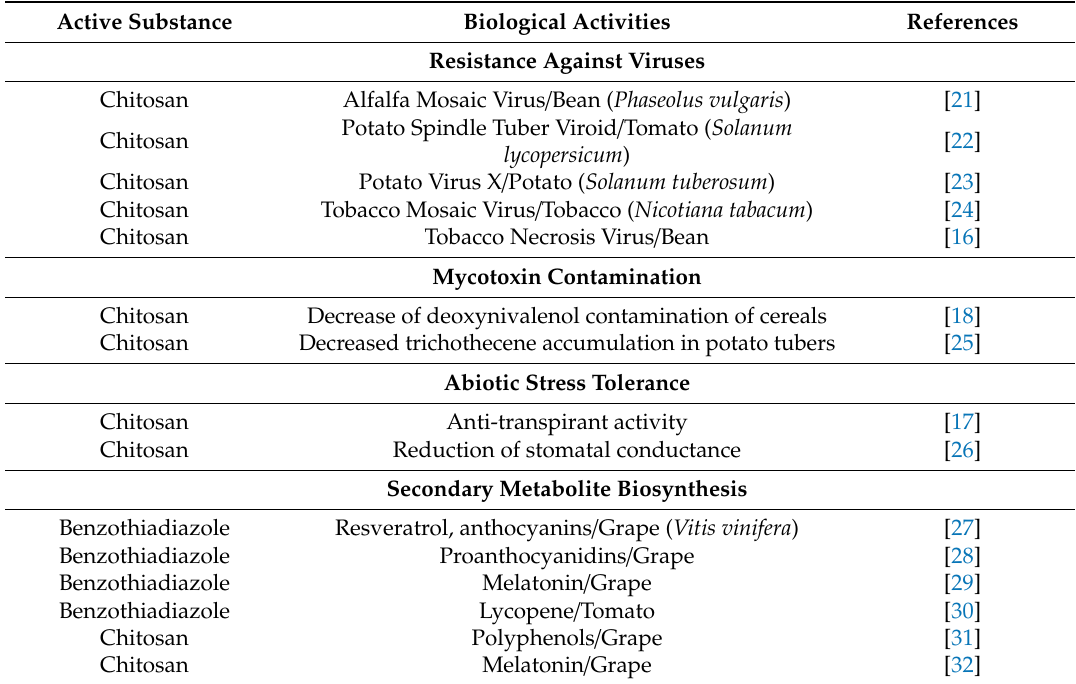
Table 3. Main biological activities of the most investigated plant protection products activating innate immunity and systemic acquired resistance in food